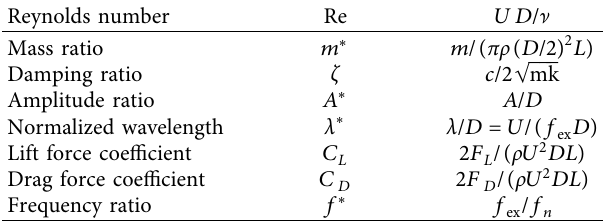
Table 1: Definition of dimensionless